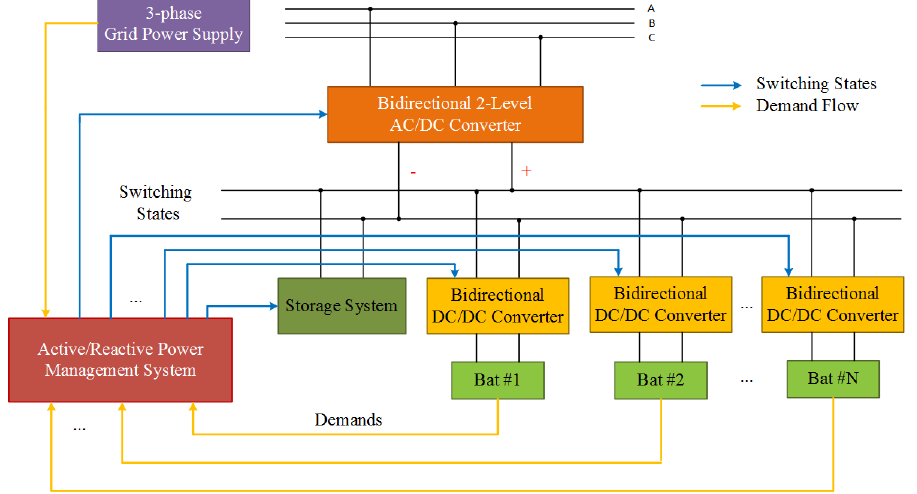
Figure 3. Framework of the smart car park system.